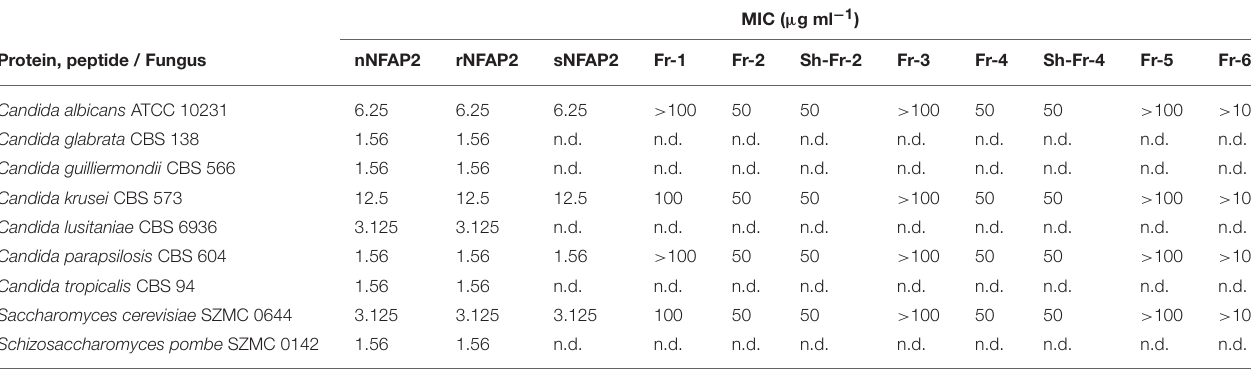
Fr-1 — Fr-6, synthetic peptide fragments 1-6 of Neosartorya fischeri antifungal protein 2 ( Table 1 and Figure 3 ), MIC, minimal inhibitory concentration, n.d., not determined, nNFAP2, native NFAP2 produced by N. fischeri NRRL 181, rNFAP2, recombinant NFAP2 produced by P. chrysogenum nfap2, Sh-Fr-2 and Sh-Fr-4, shuffle variant of Fr-2 and Fr-4s, NFAP2, synthetic